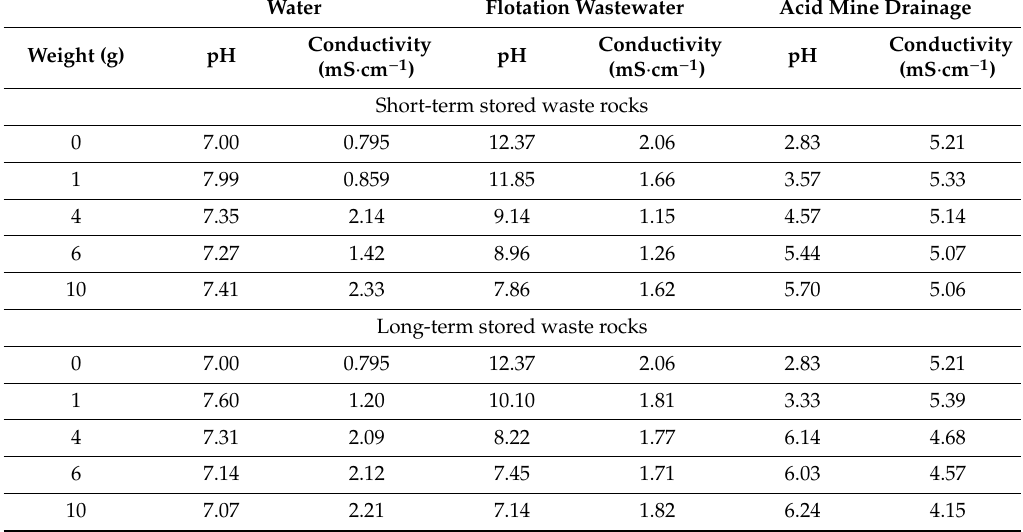
Table 5. Waste rocks stored for a short and long amount of time treated with water, flotation wastewater, and AMD. The pH and conductivity were measured after 84 h of